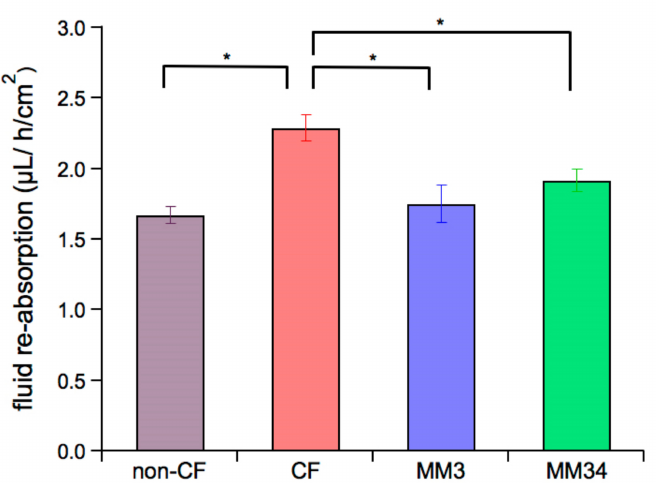
Figure 4. Impact of the anionophores on net fluid re-absorption in CF epithelia. Bars indicate the fluid re-absorption rate measured after 24 h of incubation. Untreated CF ( n = 7) and non-CF ( n = 9) epithelia were incubated with 0.1% DMSO as control. CF epithelia were incubated with 0.25 µ M of MM3 ( n = 7) or 0.25 µ M of MM34 ( n = 7). Data were obtained from two non-CF donors and two di ff erent homozygous F508del-CFTR patients. Mean values ± SEM are shown. The asterisk (*) indicates